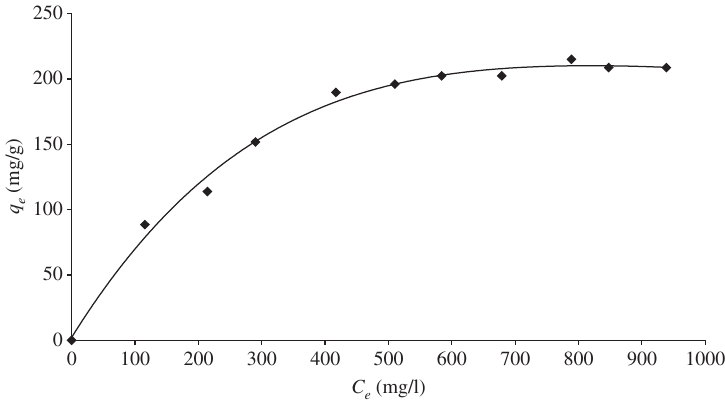
Figure 4: Equilibrium adsorption isotherm of Pb(II) onto S. sesban L. at 30 ° C. [Adsorption conditions employed: pH, 4.5; adsorbent concentration, 0.3 g/l; adsorption temperature, 30 ° C; agitation time, 2h; particle size, 50–150 μ